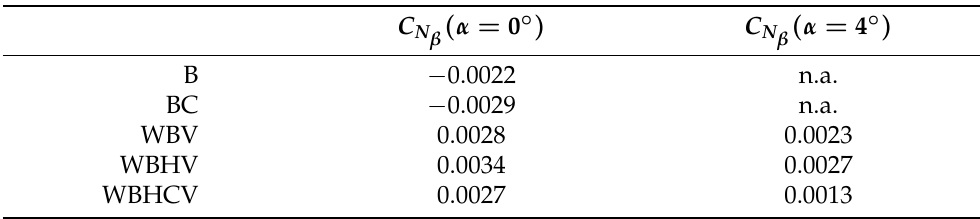
Table 8. Aircraft configurations and directional stability derivatives. Reference point at x CG = 0, V = 35m/s, Re =